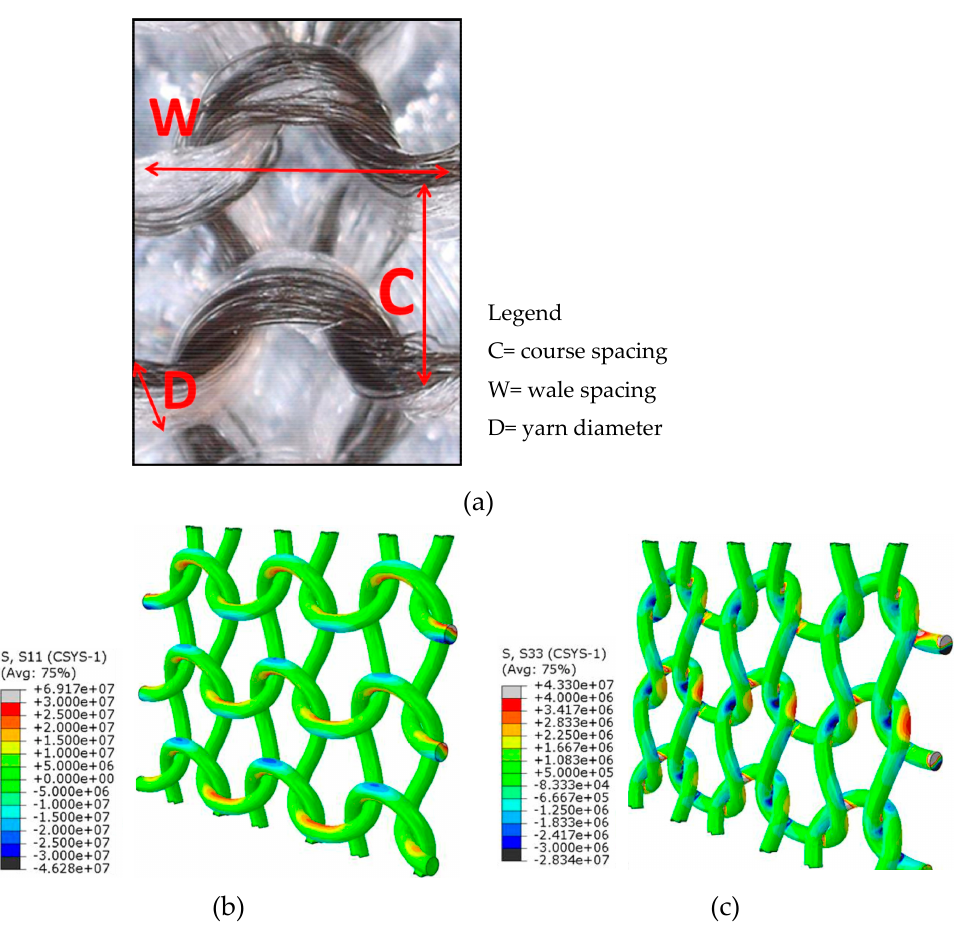
Figure 16. An example of refined FE modelling of textile structures: (a) Microscopy image of the reference knitted textile architecture, with evidence of local stresses due to mechanical interactions; (b) in-plane and (c) out-of-plane stress peaks (values in Pa; figures reproduced from [94] with permission from Elsevier, license n. 4581300089691, May 2019).